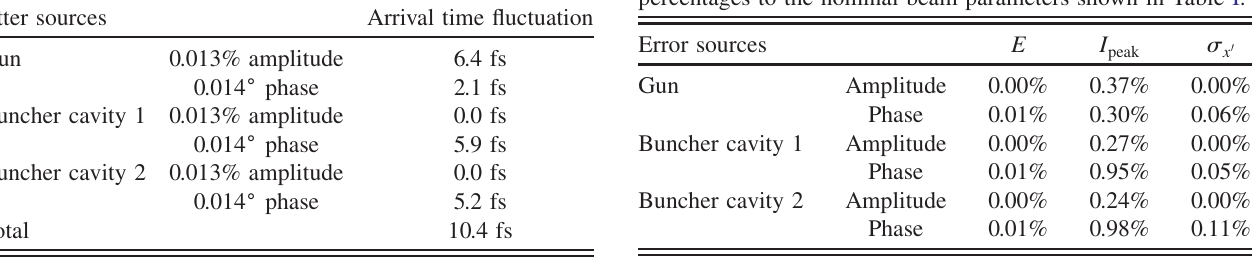
TABLE IV. Beam energy ( E ), peak current ( I peak ), and beam transverse divergence ( (cid:6) x 0 ) variations at the sample caused by rf error, 0.013% amplitude and 0.014 (cid:3) phase from the nominal conditions, at the gun and buncher. The variations are shown as percentages to the nominal beam parameters shown in Table